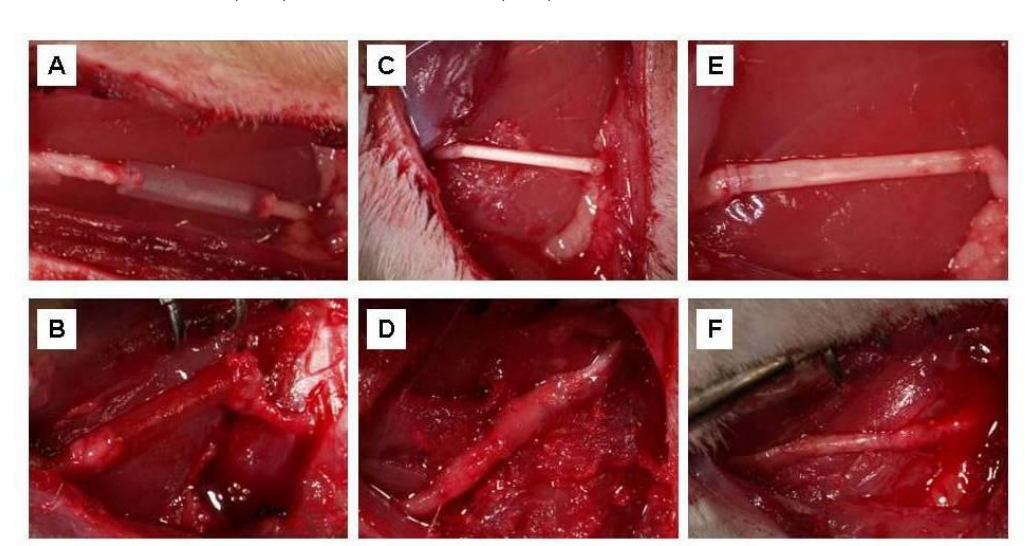
Figure 4. Intraoperative photographs of different types of nerve conduit (top row, immediately after implantation; bottom row, six months after implantation): ( A , B ) Silicone tube (used as a control); ( C , D ) PLLA conduit; ( E , F ) PLLA/ODLA-AG73 conduit.